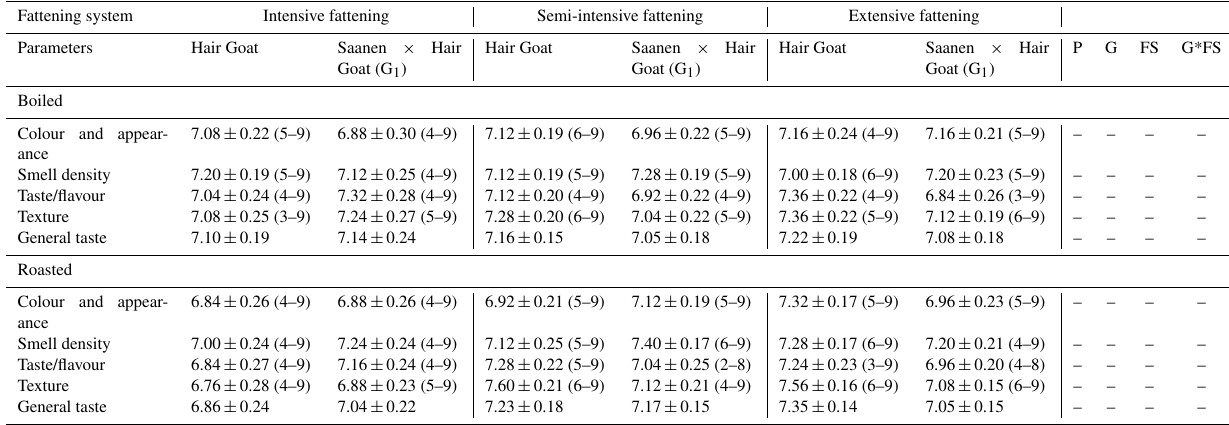
Table 5. Sensory attributes of Hair Goat and Saanen × Hair Goat (G 1 ) crossbred kids. Fattening system